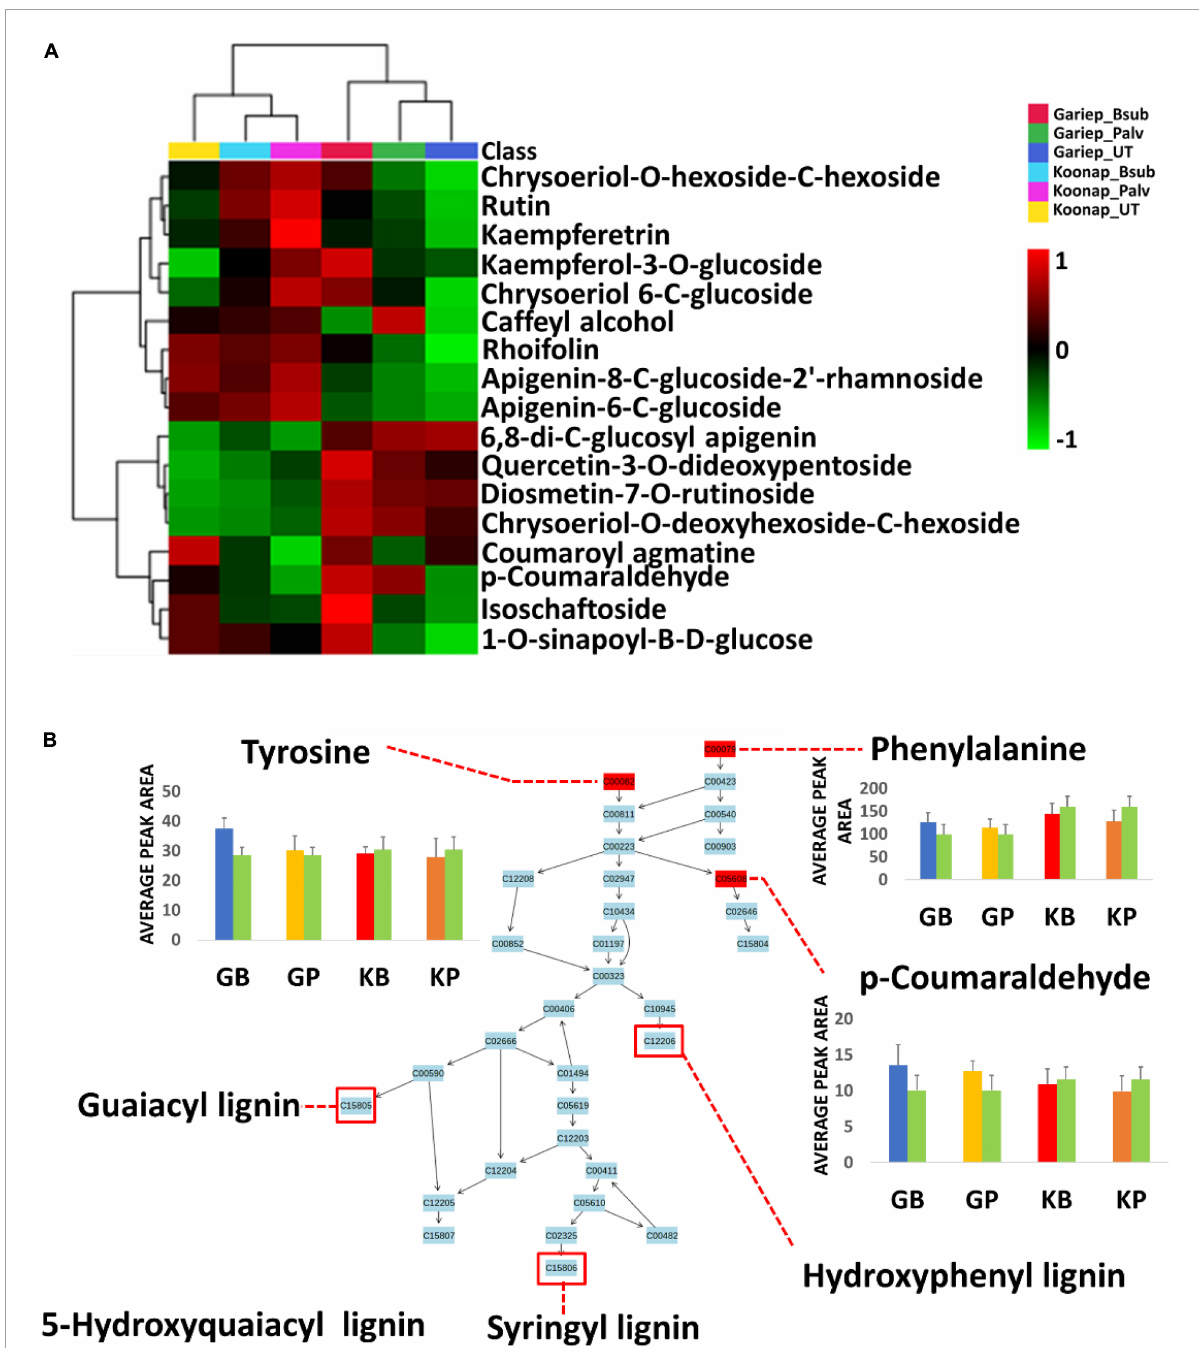
FIGURE9 Comprehensive metabolic pathways analysis and metabolome view. (A) A heatmap displaying differential quantitative alterations in the concentrations of the selected phenylpropanoids. The heatmap show the up/down-regulation of some phenolic compounds in the plant growth-promoting rhizobacteria (PGPR)-treated and untreated wheat cultivars, an indication of the potential impact of PGPR treatment on secondary metabolite biosynthesis and the regulation of the secondary metabolic pathway. (B) Topology map of the phenylpropanoid biosynthesis pathway, indicating the integration of precursor molecules (tyrosine, phenylalanine, and tryptophan) at differentially altered quantification levels at under different conditions. GB (Blue) = Gariep_ B. sub , GP (yellow) = Gariep_ P. alvei , KB (red) = Koonap_ B. sub , KP (orange) = Koonap_ P. alvei . Green bars represent untreated samples for the respective cultivars. The end products of the phenylpropanoid biosynthesis pathways are indicated in red demarcations as